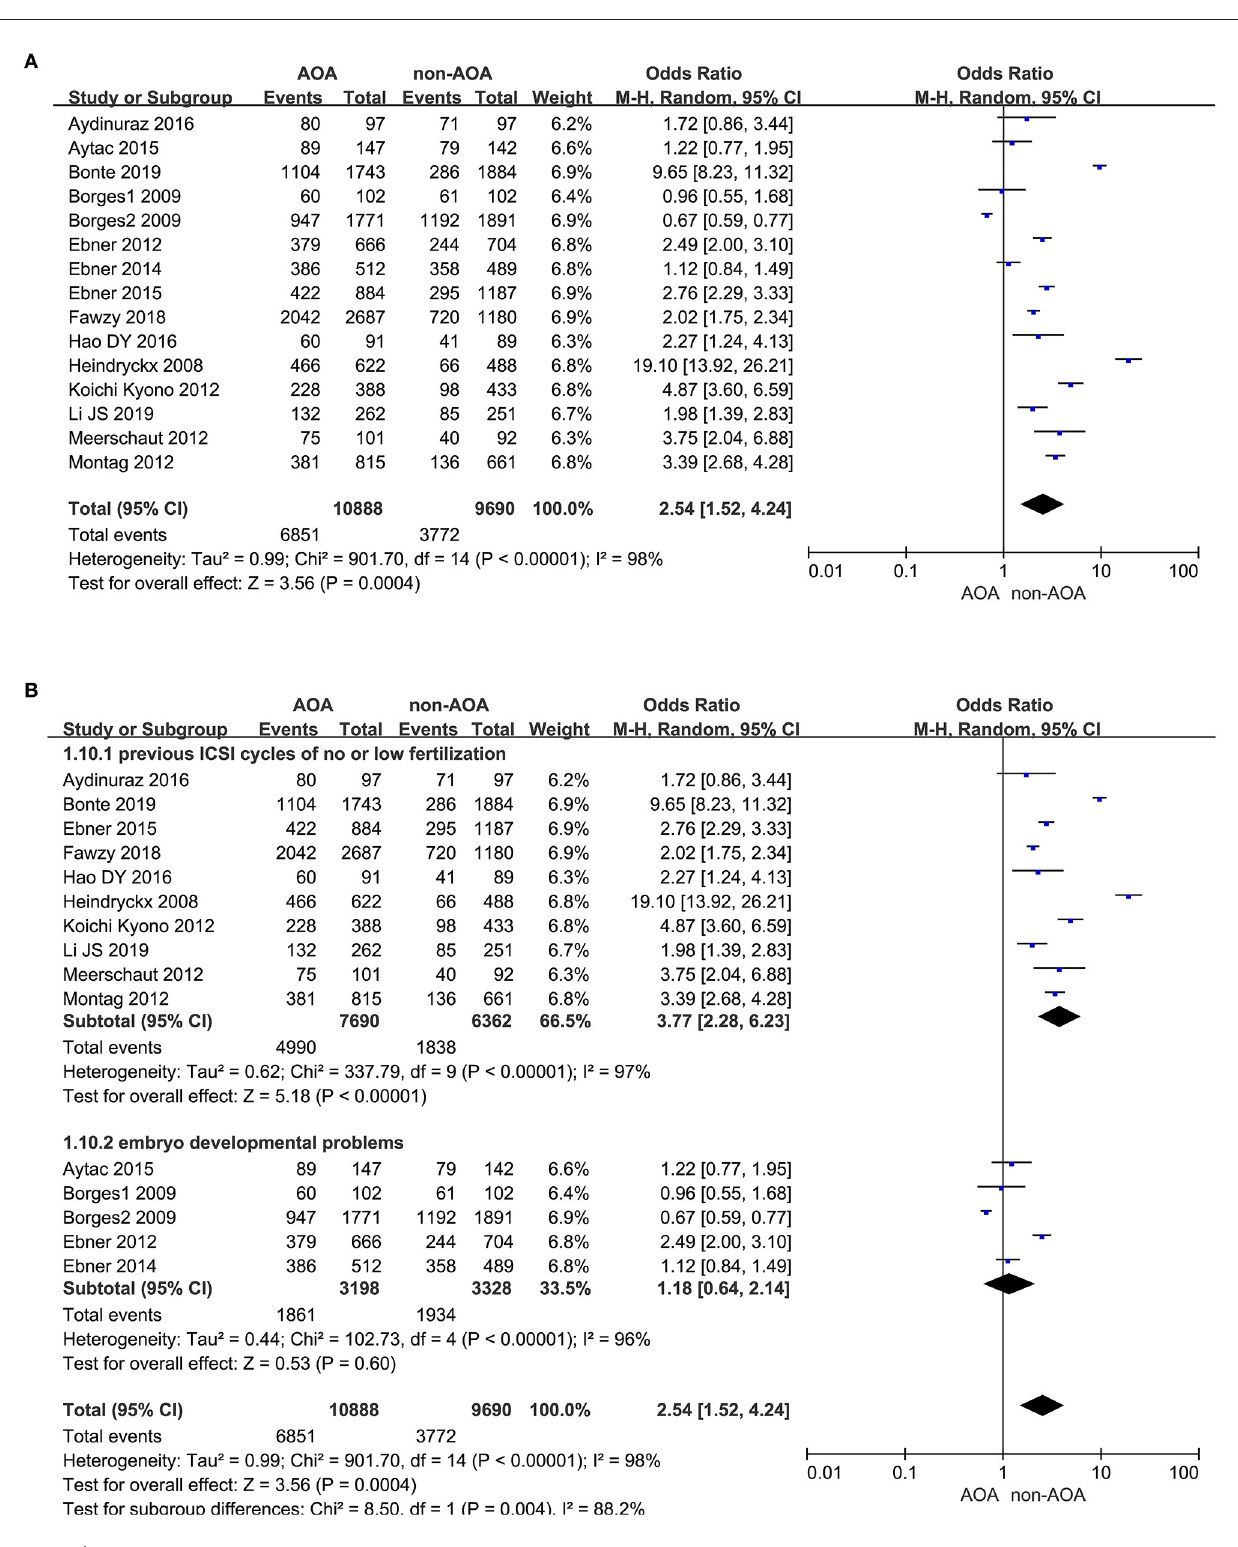
Frontiers in Physiology |